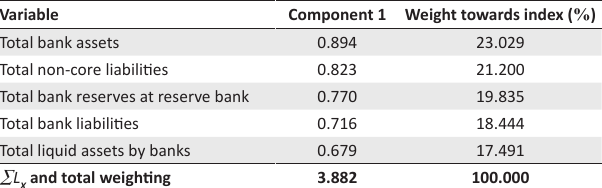
TABLE 7: Component loadings of South African bank balance sheet conditions. Variable